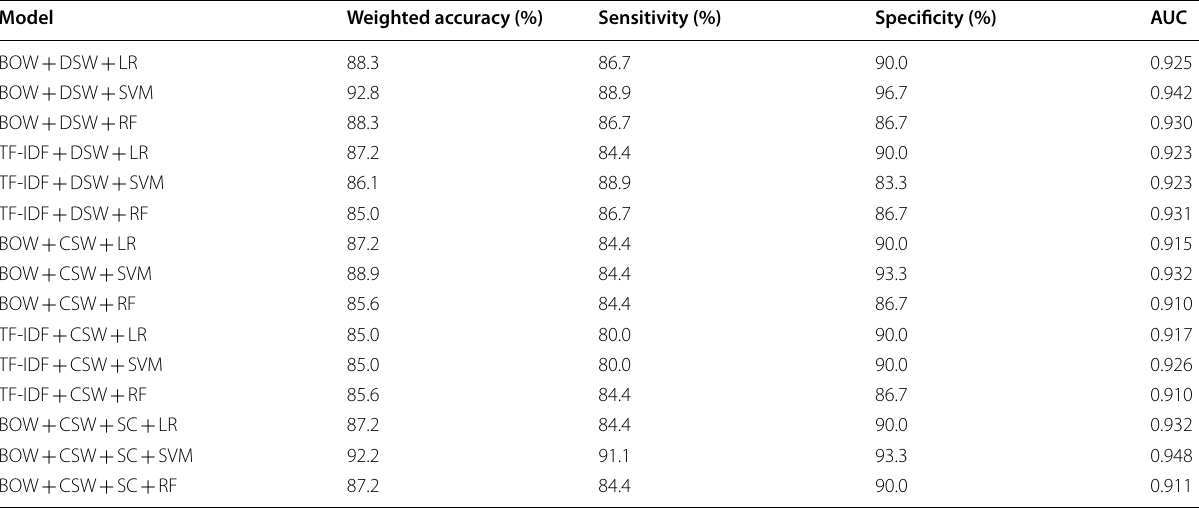
Table 2 Binary classifier evaluation metrics on test